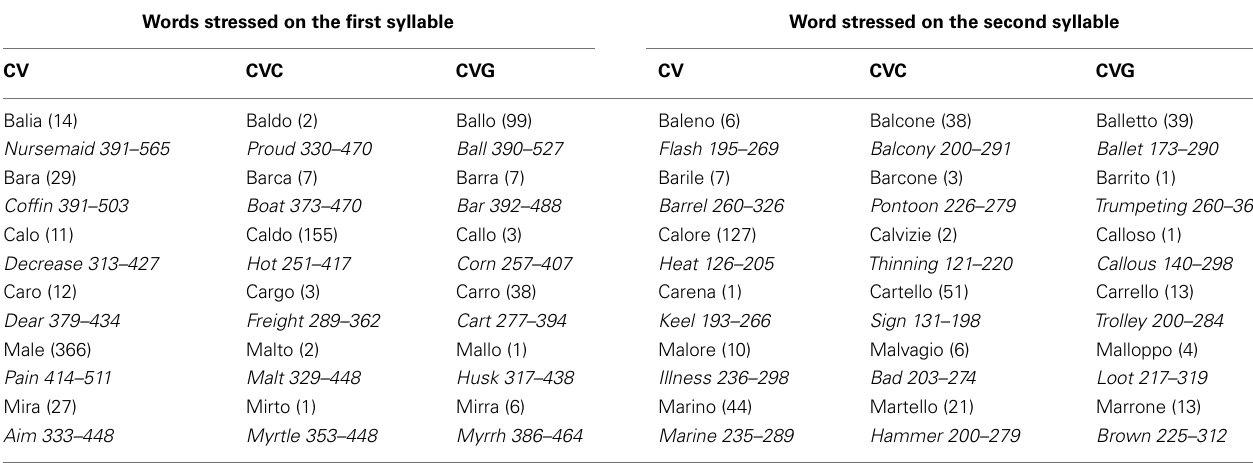
TableA1 | List of test stimuli, with English translation in italics and raw frequency under brackets (from COLFIS, Laudanna et al., 1995). Numbers in italic correspond respectively to the duration of the CV portion and the CVC portion in each